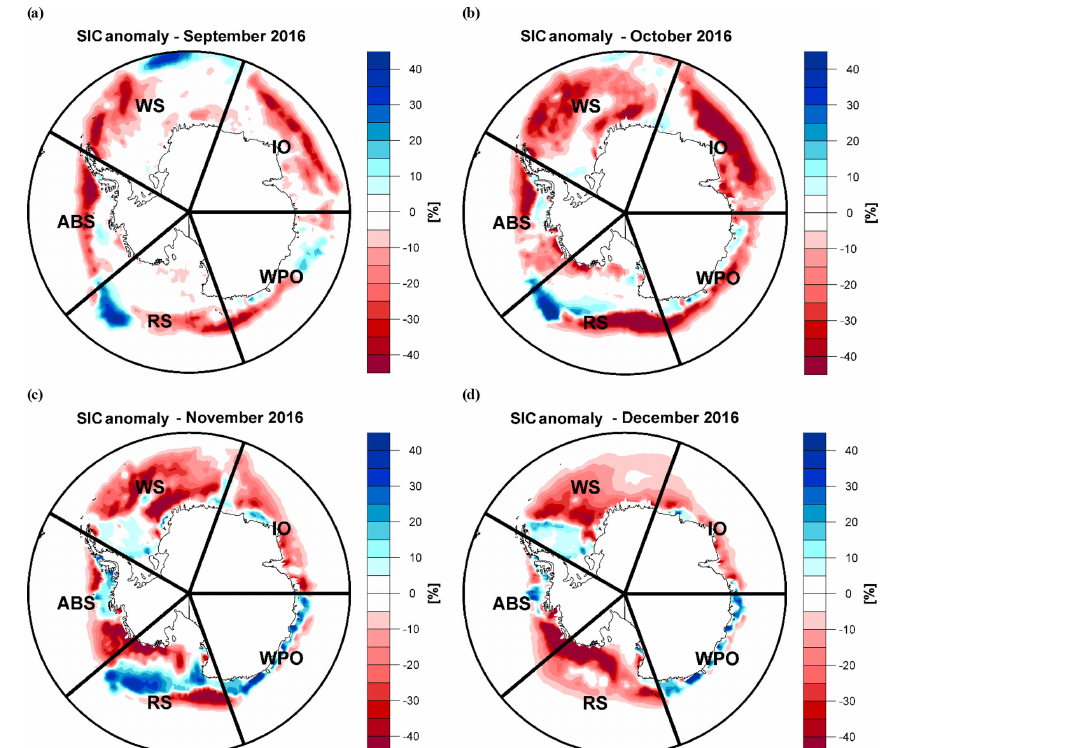
Figure 1. Sea ice concentration (SIC) anomalies 2016 for (a) September, (b) October, (c) November, and (d) December. The anomalies are computed relative to the reference period 1979–2010. WS: Weddell Sea; IO: Indian Ocean; WPO: western Pacific Ocean; RS: Ross Sea; ABS: Amundsen–Bellingshausen